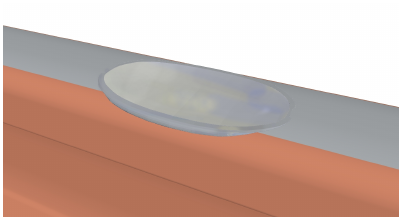
Figure 4. Three-dimensional representation of a wheelburn defect.